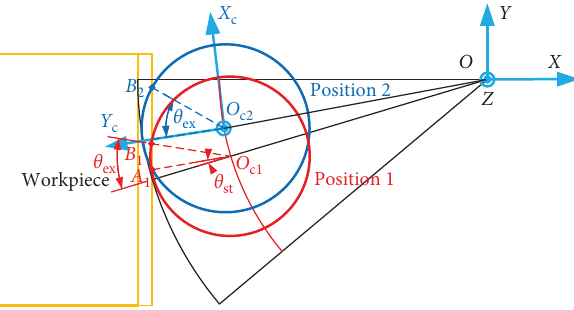
Figure 11: The dynamic entry and exit